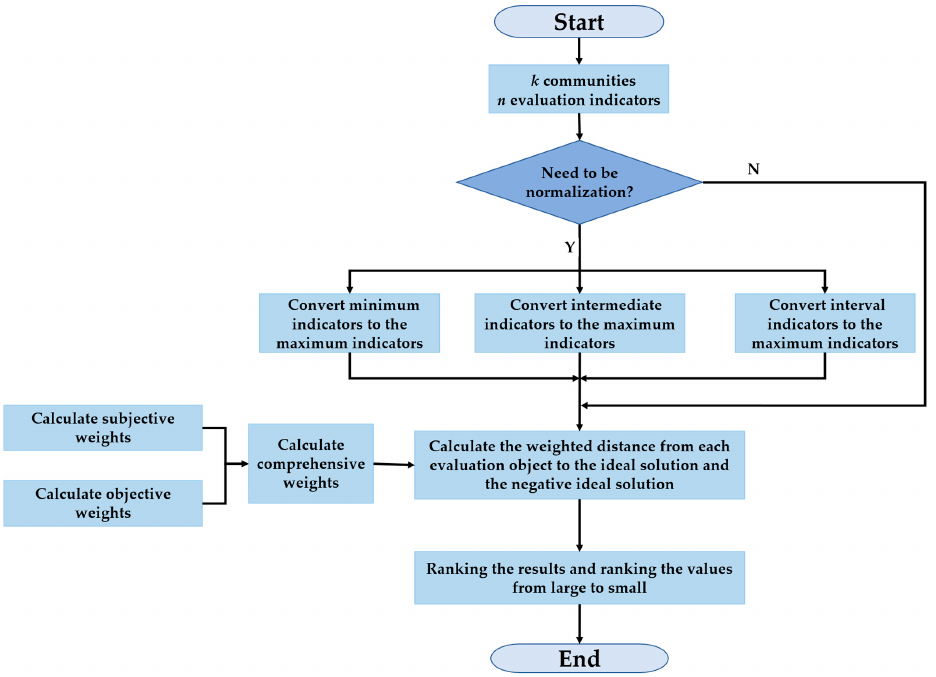
Figure 4. The algorithm flow chart.